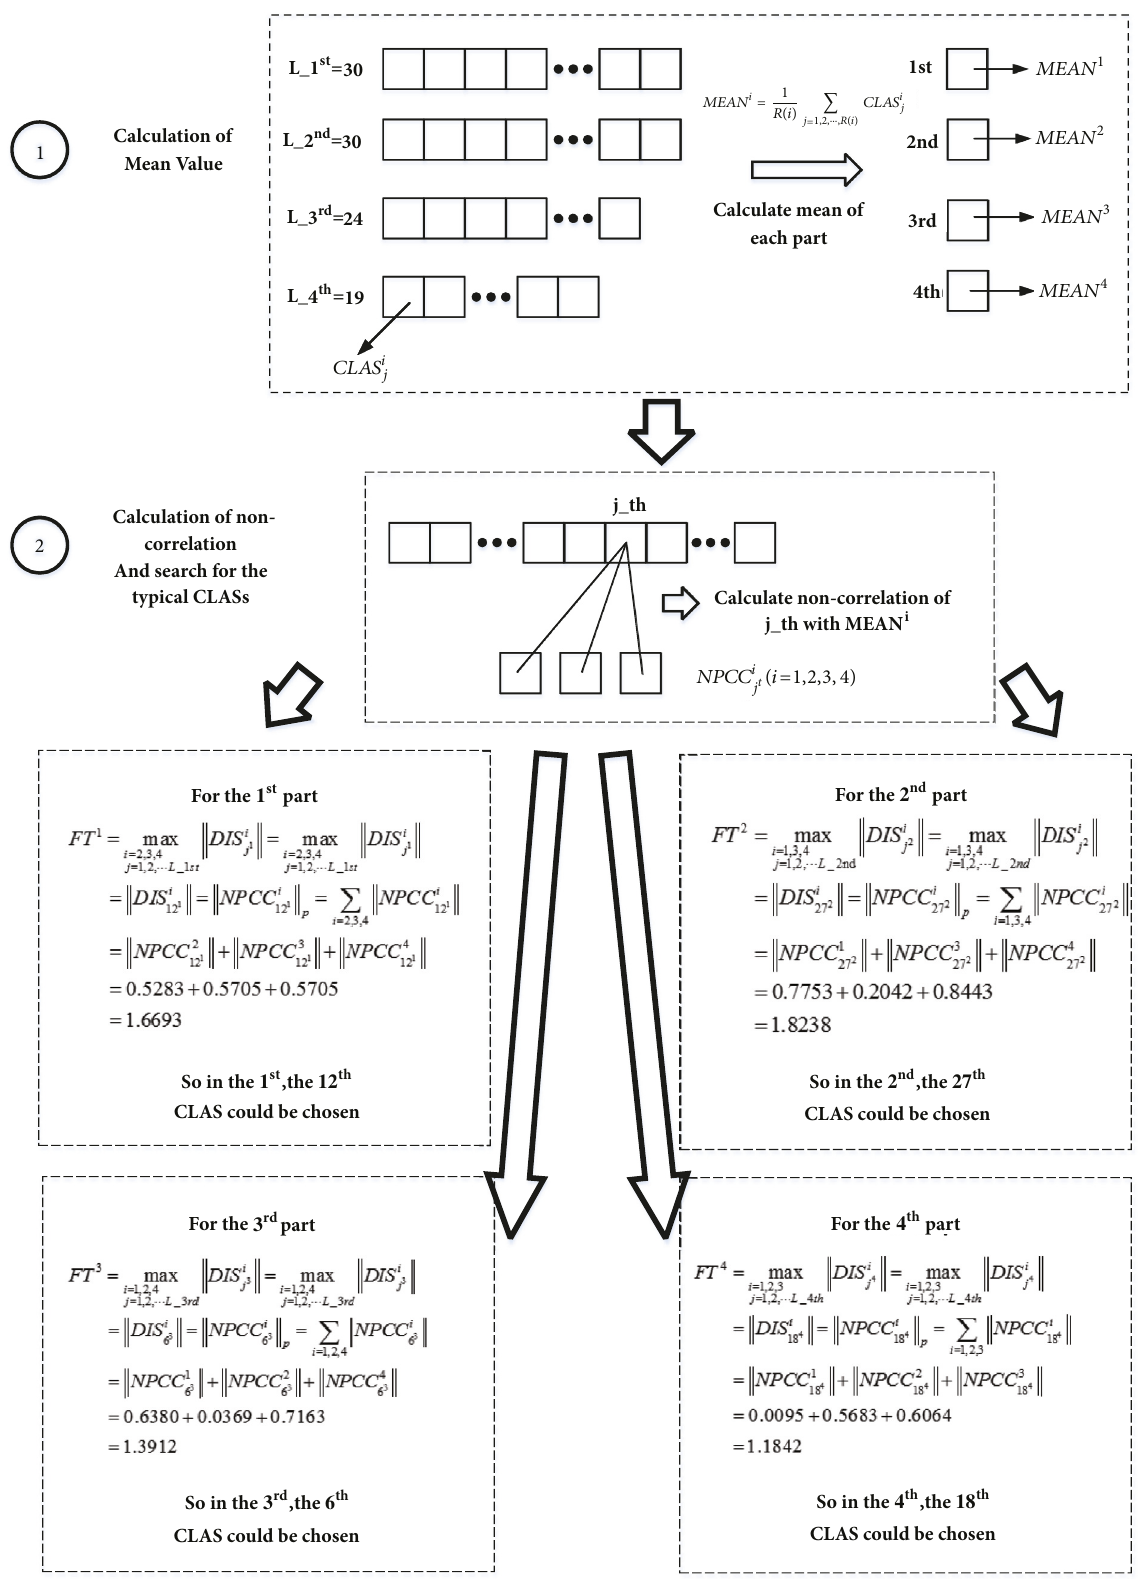
Figure 17: Steps 3 and 4 in proposed algorithm of sample